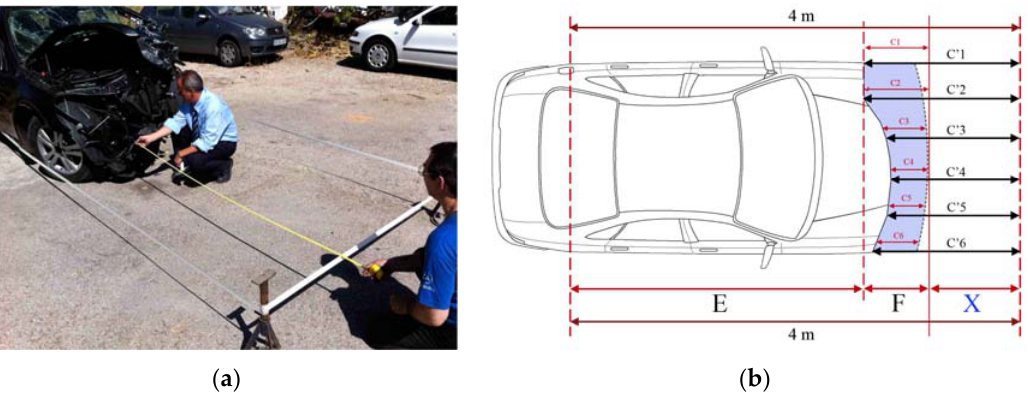
Figure 1. Classical protocol: ( a ) procedure used to take the measurements, and ( b ) graphical representation of the measurements considered during the energetic analysis.